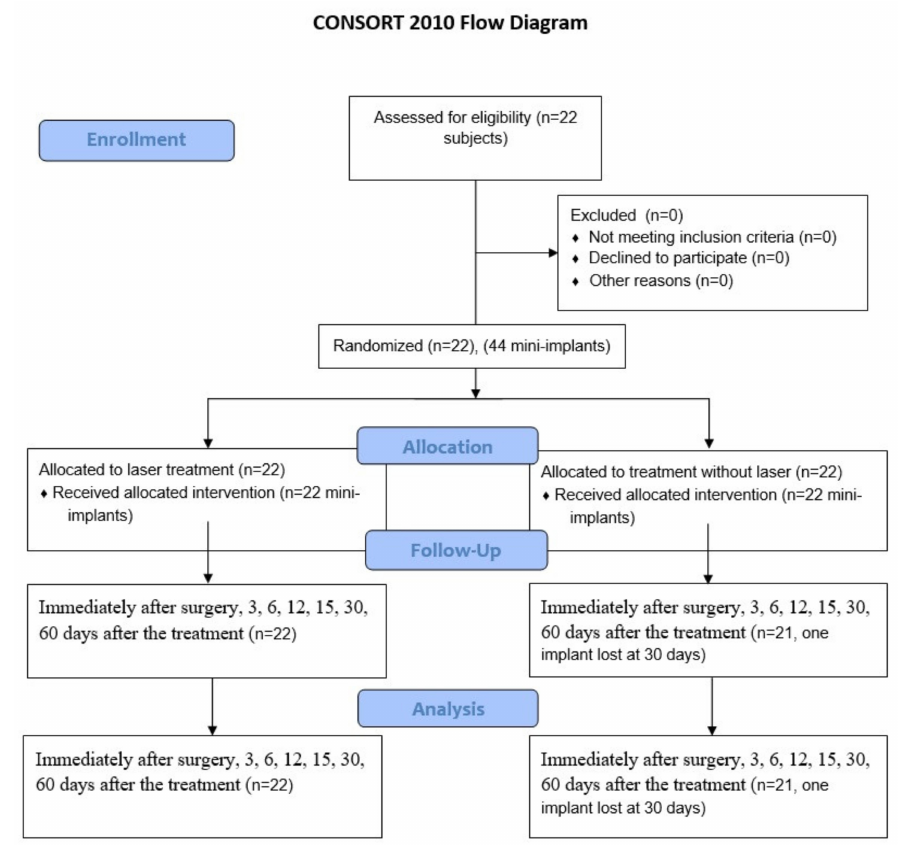
Figure 1. CONSORT 2010 flow diagram used in the research to help to assess for eligibility of